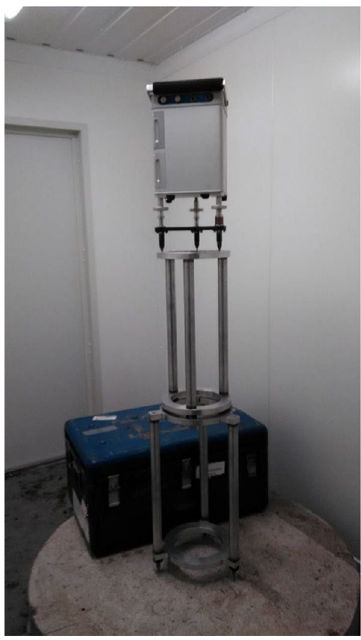
Fig. 15 Measuring setup at Þeistareykir for determination of the free-air vertical gravity gradient with the help of a CG5 Scintrex gravity meter and a tripod; gravity measurements were performed directly on the concrete pillar, at 60 cm and at 120 cm above the